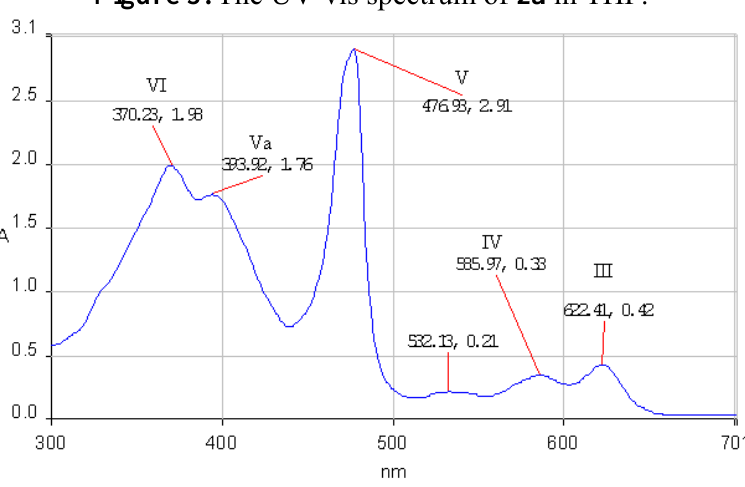
Figure 3. The UV-vis spectrum of 2a in